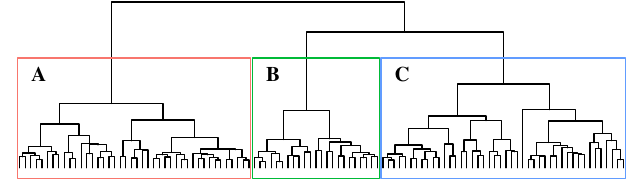
FIG. 12. Dendrogram showing the hierarchical structure of the mini-studio sessions observed. Clusters A, B, and C are indicated in the boxes.